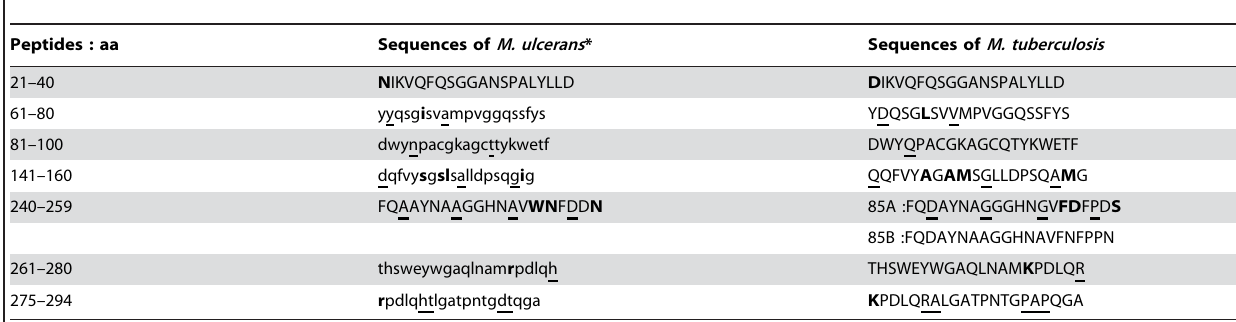
Table 1. Immunodominant peptides of Ag 85 A from M. ulcerans and M. tuberculosis .